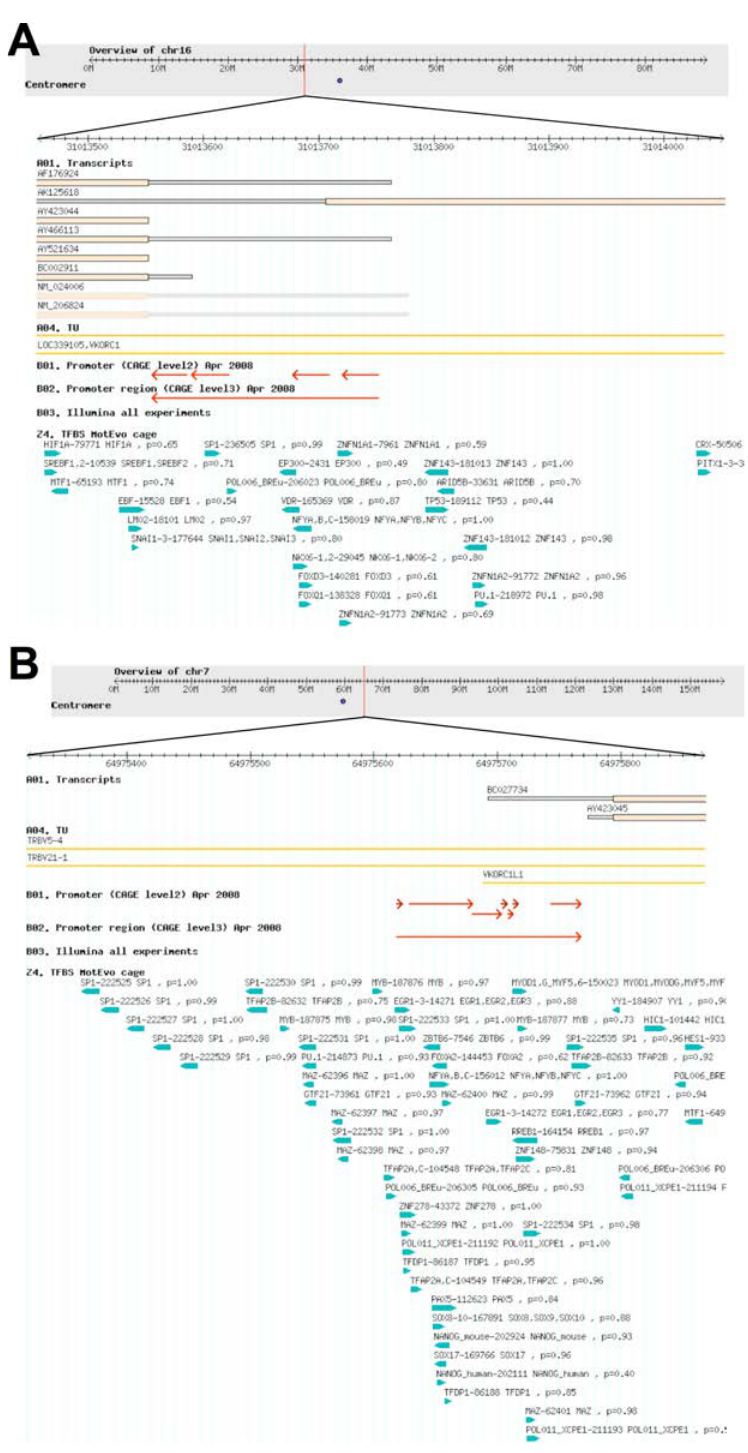
Figure 4. Overview of (top to bottom) chromosome maps (grey fields) showing genetic loci (vertical red lines), alternative mRNA transcripts (A01. Transcripts, tan bars), transcription start sequences (B01. Promoter (CAGE level 2, red arrows) and predicted transcription factor binding sites (24. TFBS MotEvo cage, blue arrows) for ( A ) human VKORC1 ; and ( B ) human VKORC1L1 . Graphics are from the FANTOM4 Human (hg18) genome viewer (see Note 5 [104]).